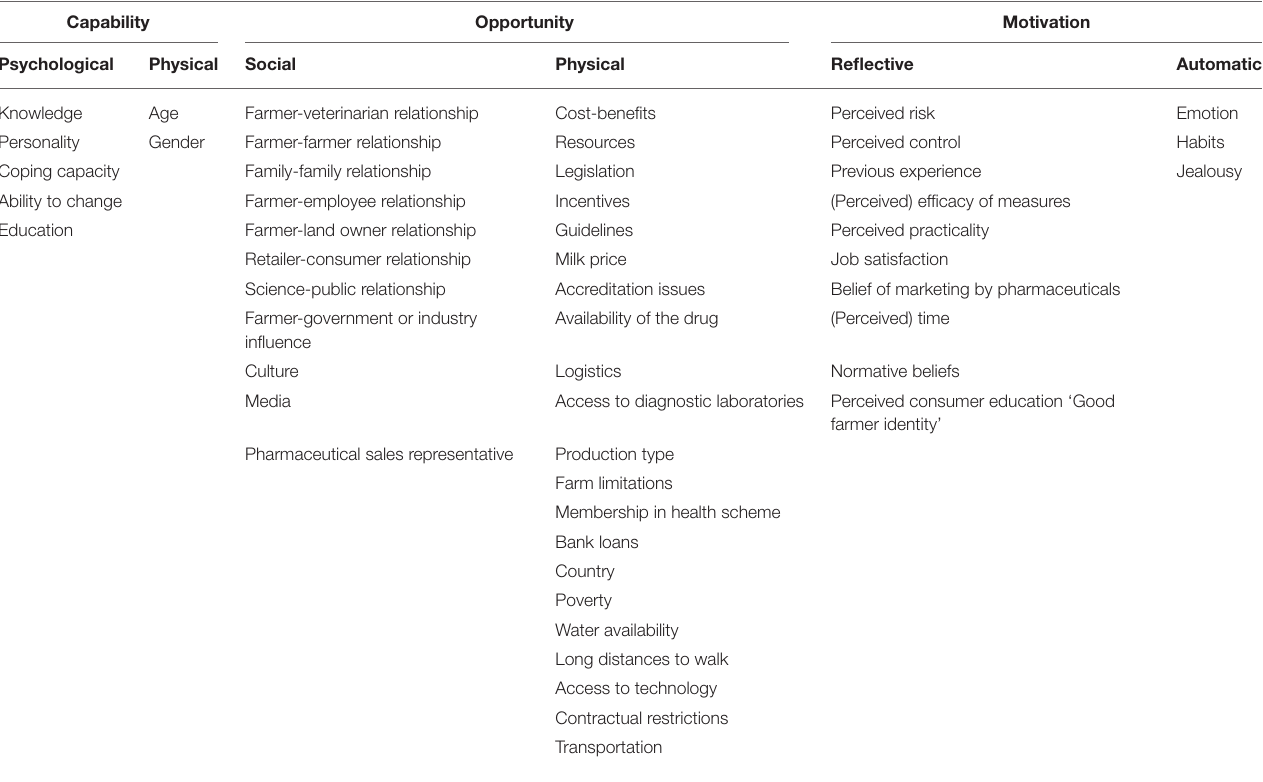
TABLE 5 | Summary of constructs of farmers’ behavior described in 146 reviewed studies related to cattle disease control mapped in a COM-B model and indexed in Pubmed or Web of Science.